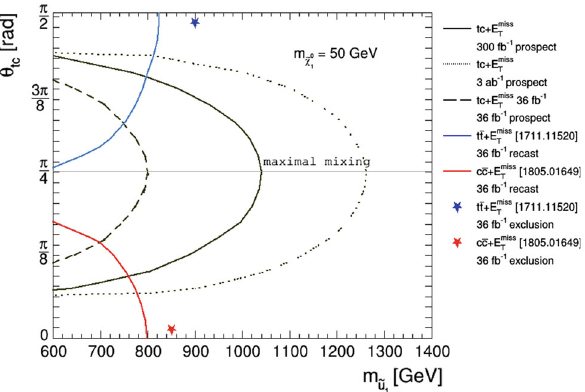
) plane. 1 ( c ¯ c + T analysis. See T